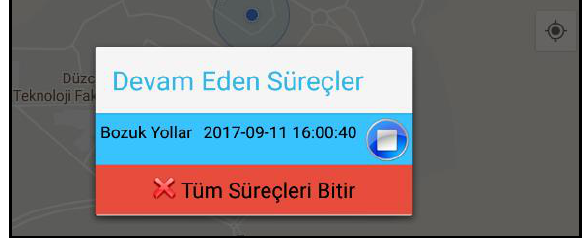
Figure 4. Displaying continuing processes of road disturbance